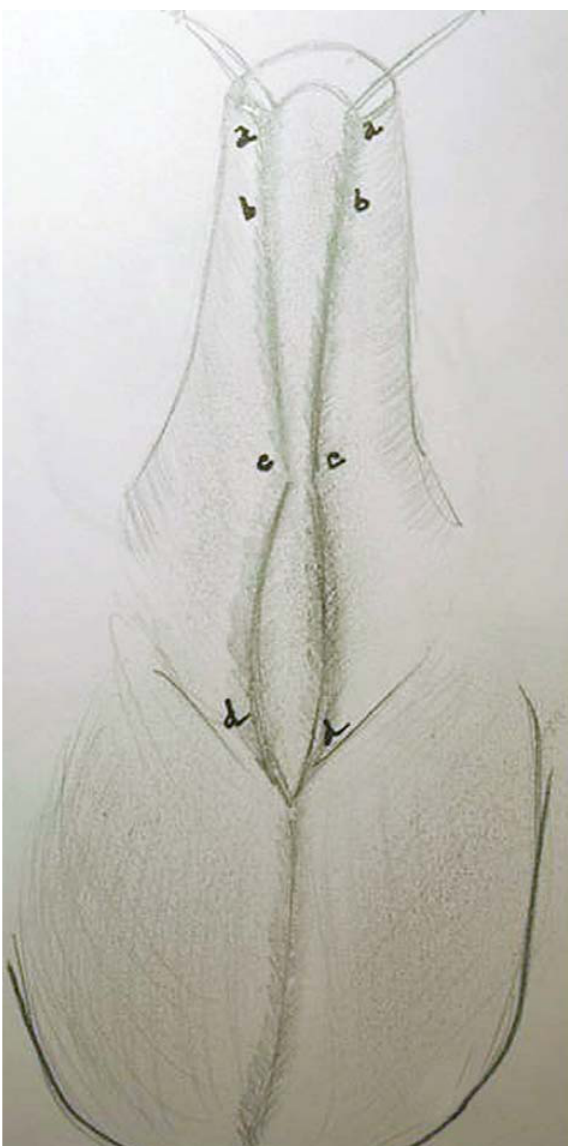
Figure 5 – Traction in the ventral preputial ring changing the broken incision into a strait